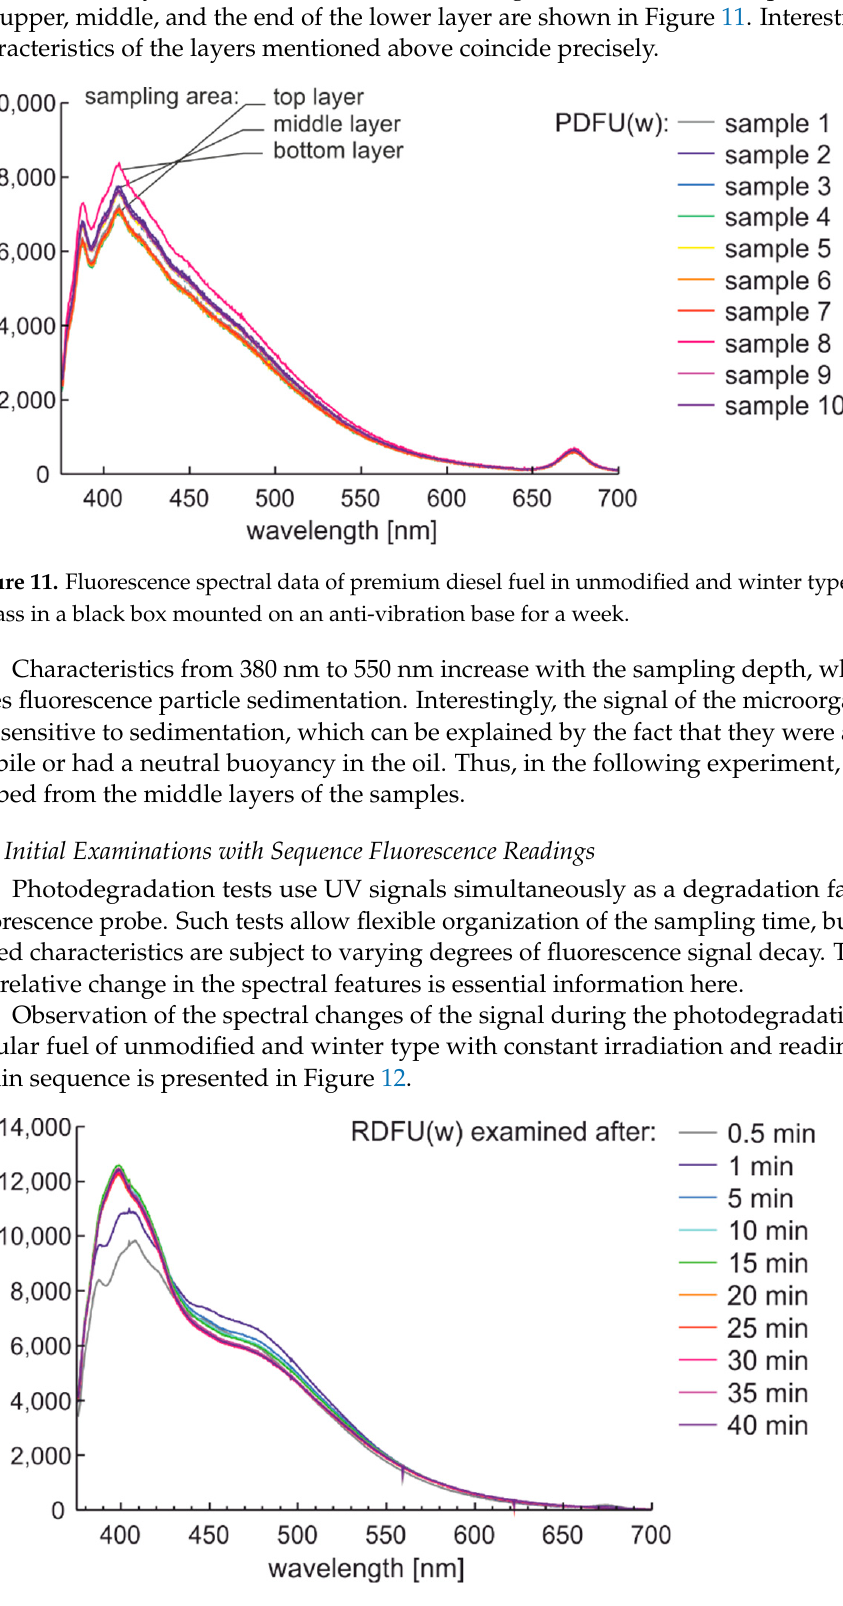
Figure 12. Fluorescence spectral data of regular diesel fuel unmodified and winter type examined with UV signal with constant irradiation and reading with a 5-min sequence.